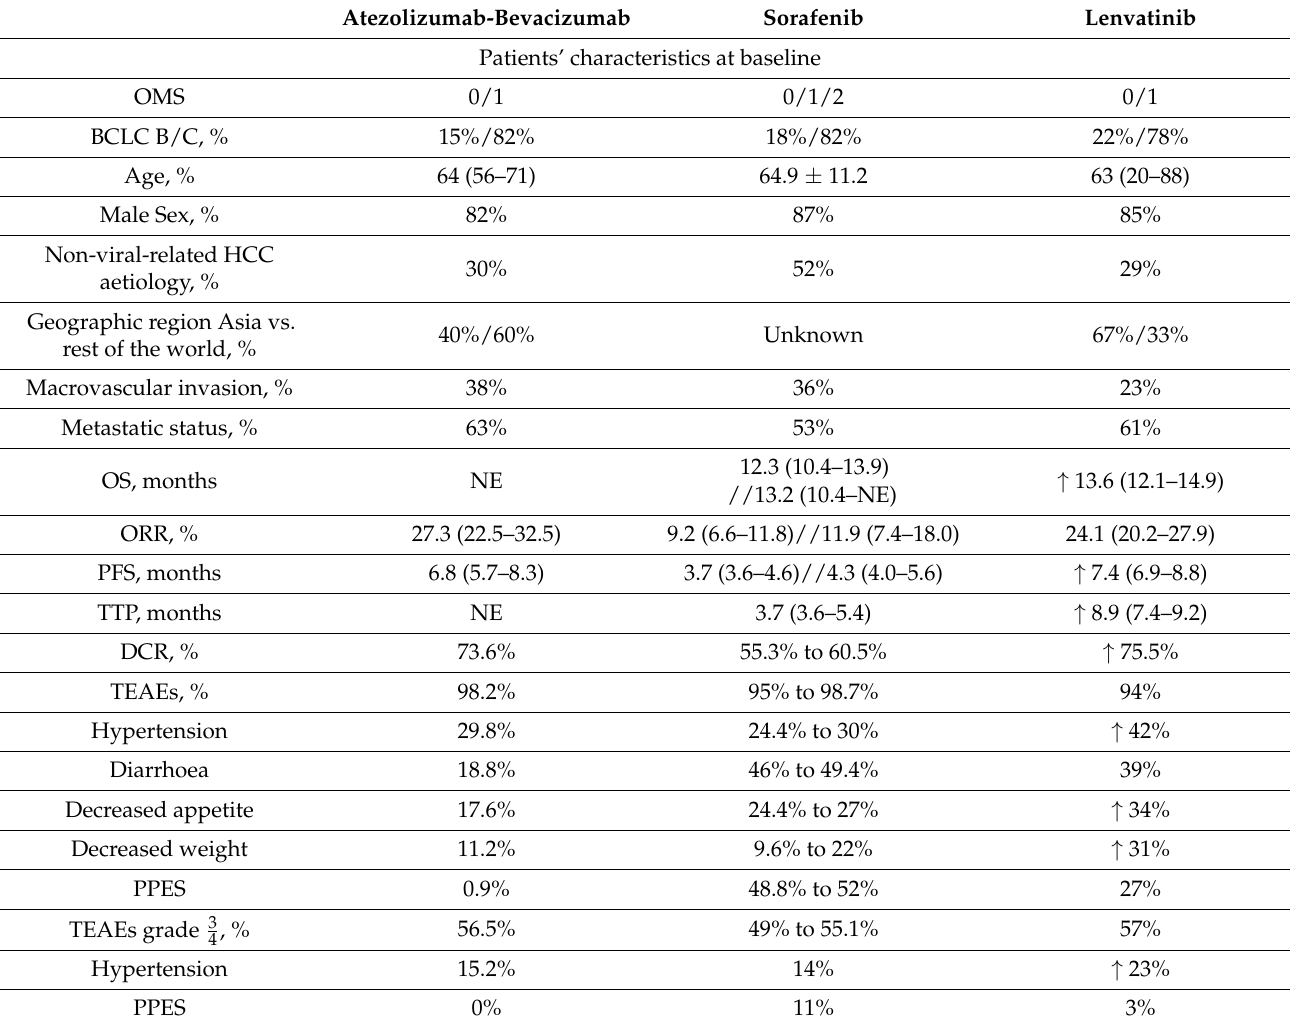
Table 1. Summary of first-line validated treatments for unresectable HCC based on the results of the REFLECT and IMbrave150